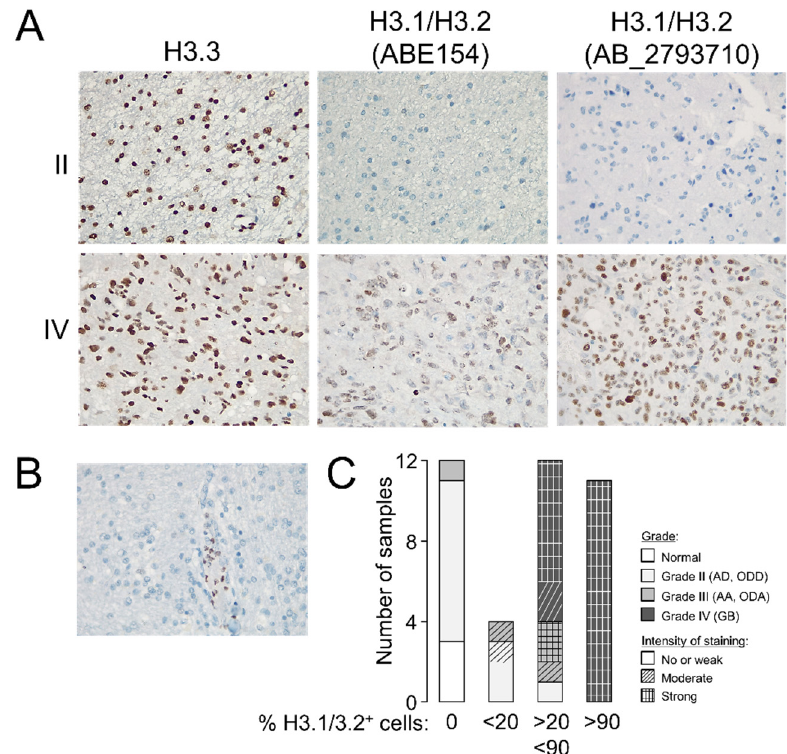
Figure 2. Staining patterns of the histone H3 variants in glioma. ( A ) Representative immunohistochemistry images in grade II and IV gliomas showing the staining patterns of H3.3 and H3.1/H3.2 in the tumoral core (magnification 20 × ). ( B ) Example of a negative sample for H3.1/H3.2 staining showing positive labeling in leukocytes (magnification 20 × ). ( C ) Classification of the samples according to the number of positive cells for H3.1/H3.2 staining; histological grade refers to the morphological features observed on the slide used in the immunohistochemistry assay. Note: AD, diffuse astrocytoma; ODD, diffuse oligodendroglioma; AA, anaplastic astrocytoma; ODA, anaplastic oligodendroglioma; GB,